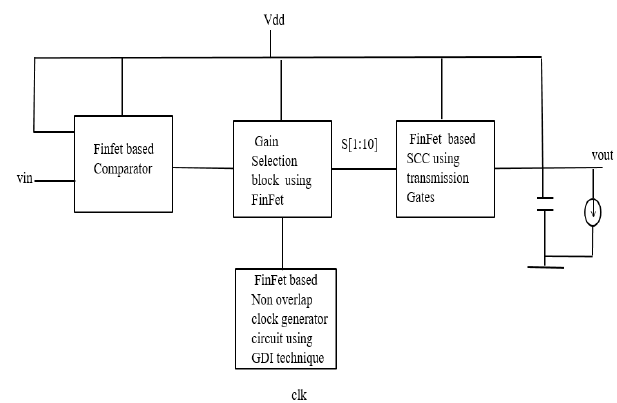
Figure 10. Block diagram of FINFET based DC to DC